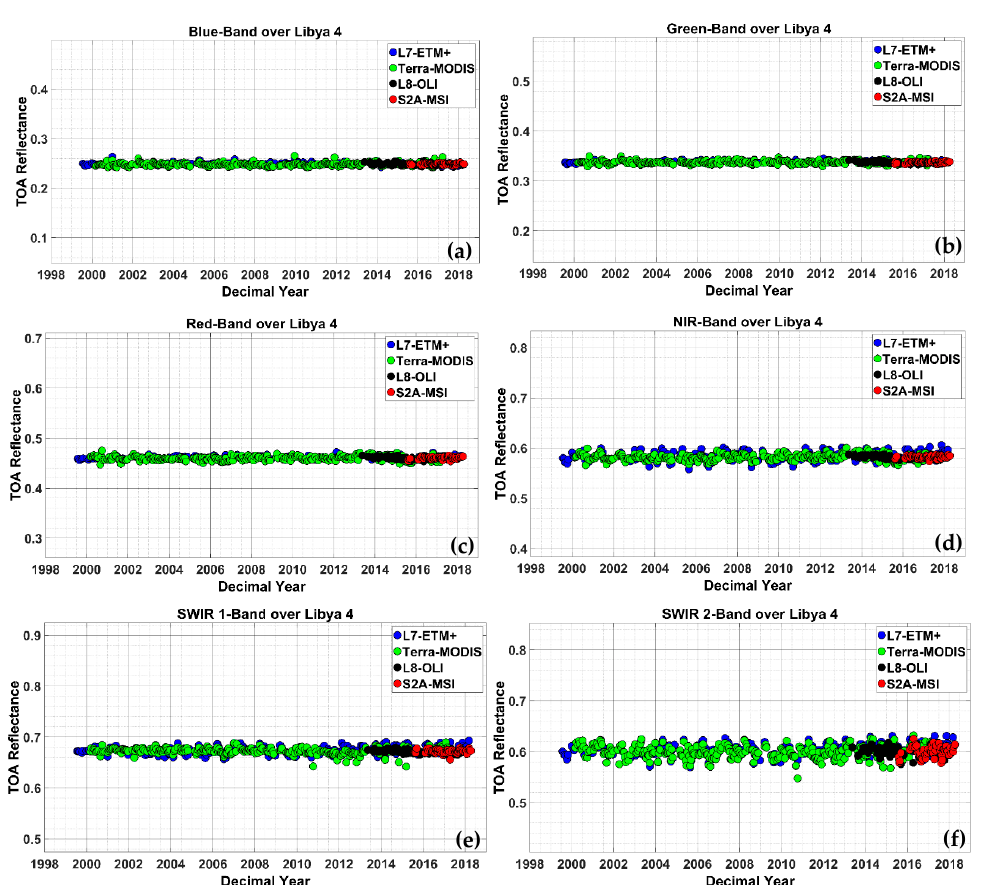
Figure 5. Temporal trend of BRDF-corrected Scaling Adjusted TOA reflectance over Libya 4 site (L7 ETM+, Terra MODIS, L8-OLI, S2A-MSI) in ( a ) blue band; ( b ) Green band; ( c ) Red band; ( d ) NIR band; ( e ) SWIR 1 band; ( f ) SWIR 2 band.